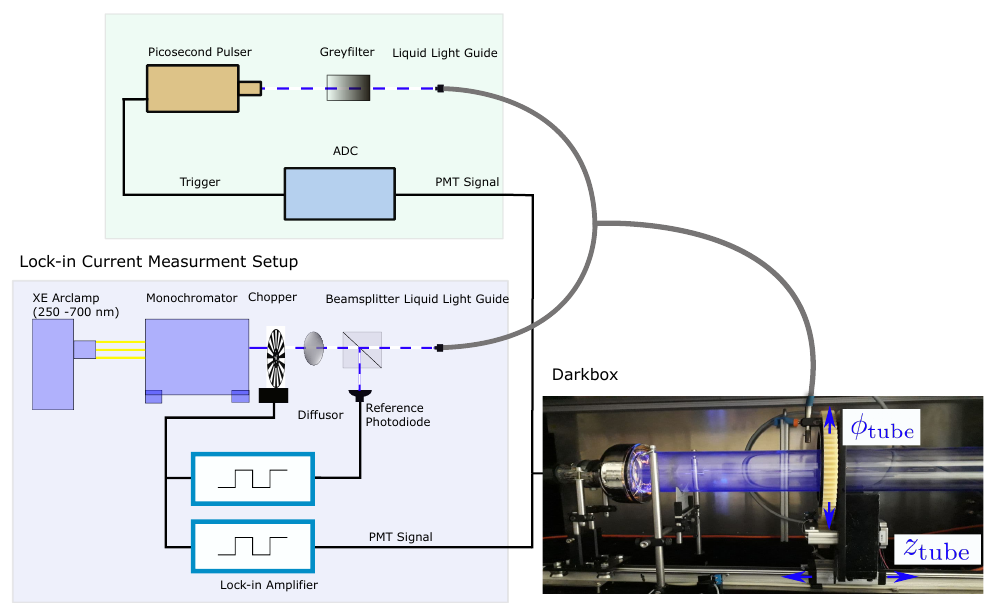
Figure 6. Schematic of the WOM test stand with a photograph of the